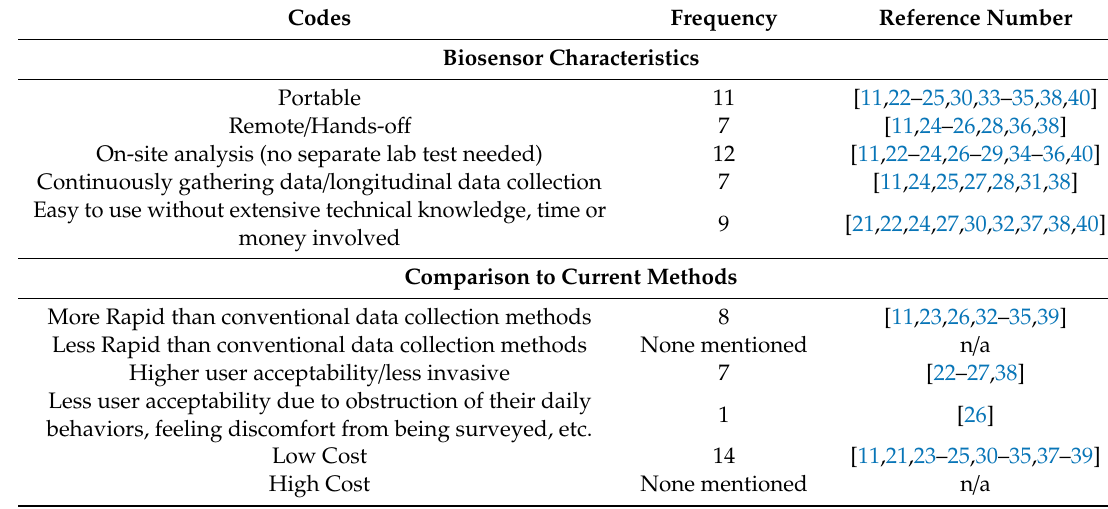
Table 3. Themes of